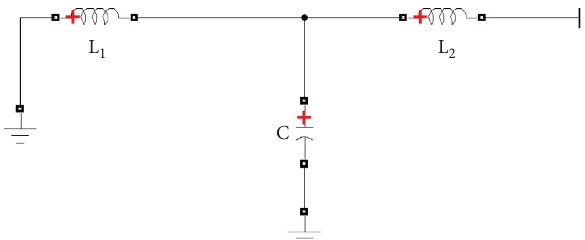
Figure 3: Transmission system equivalent model for each phase.